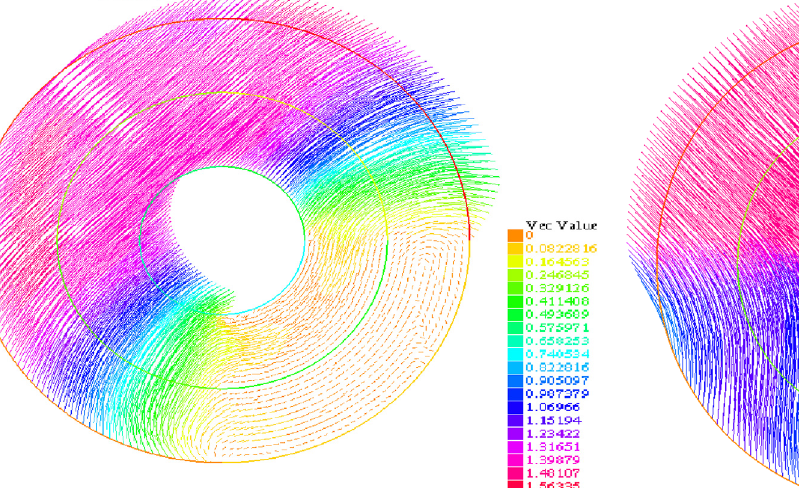
Fig. 3. Secondcasewithconstraintofdisplacementuindirection w .